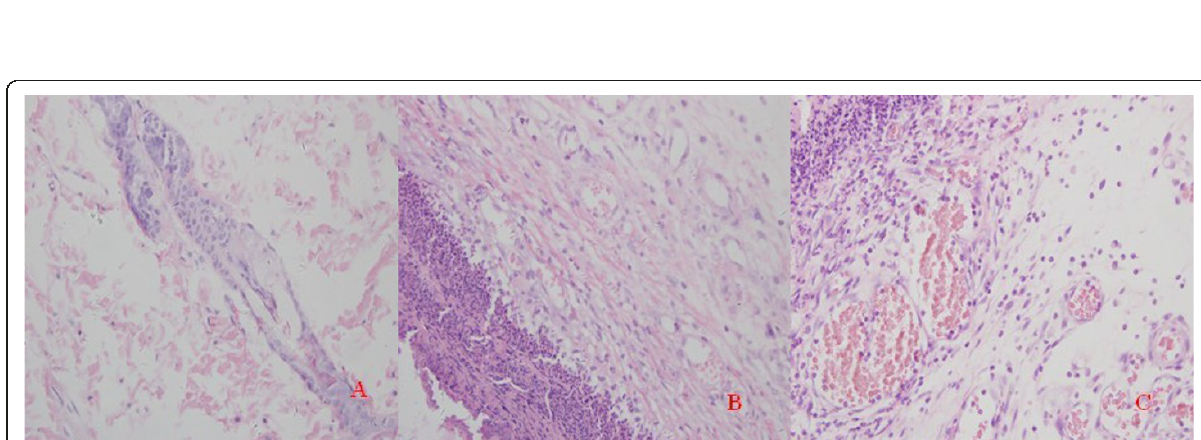
Figure 2 Morphology of Staphylococcus aureus and Klebsiella Pneumonia under scanning electron microscope . A the normal morphology of Staphylococcus aureus ; B the morphology of Staphylococcus aureus on 24 h; C the normal morphology of Klebsiella Pneumonia ; D the morphology of Klebsiella Pneumonia on 24 h